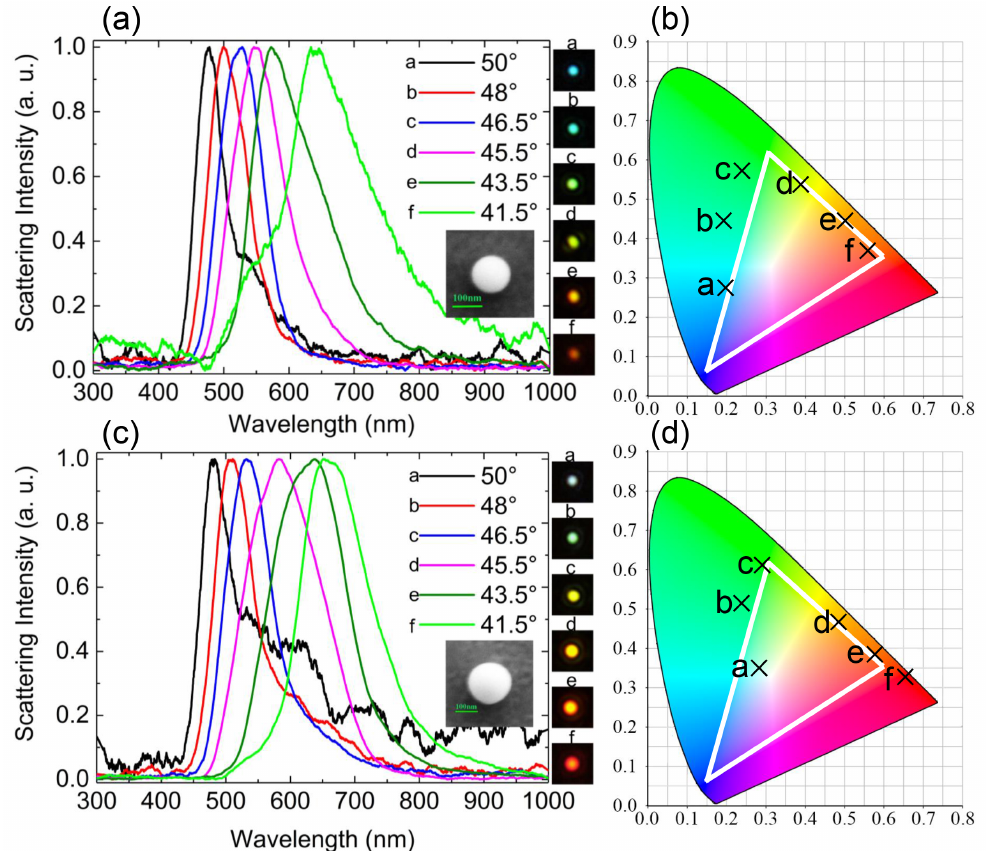
Figure 7. Measured scattering spectra of two Ga NPs with different diameters placed on the SiO 2 –SnO 2 /Ag/SiO 2 substrate. ( a ) d = 124 ± 2 nm and ( c ) d = 187 ± 2 nm. ( b , d ) are the color indices derived from the scattering spectra shown in ( a , c ). The SEM images of the Ga NPs and the corresponding radiation patterns are shown as insets in ( a , c ). The size of the optical images is 4 × 4 µ m 2